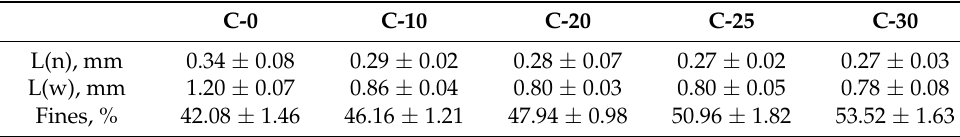
Figure 3. The particle size distribution of fibers: fibers ground 10, 20, 25, and 30 times fibers with a high-consistency refiner, respectively. Table 1. Fiber size of different treatment